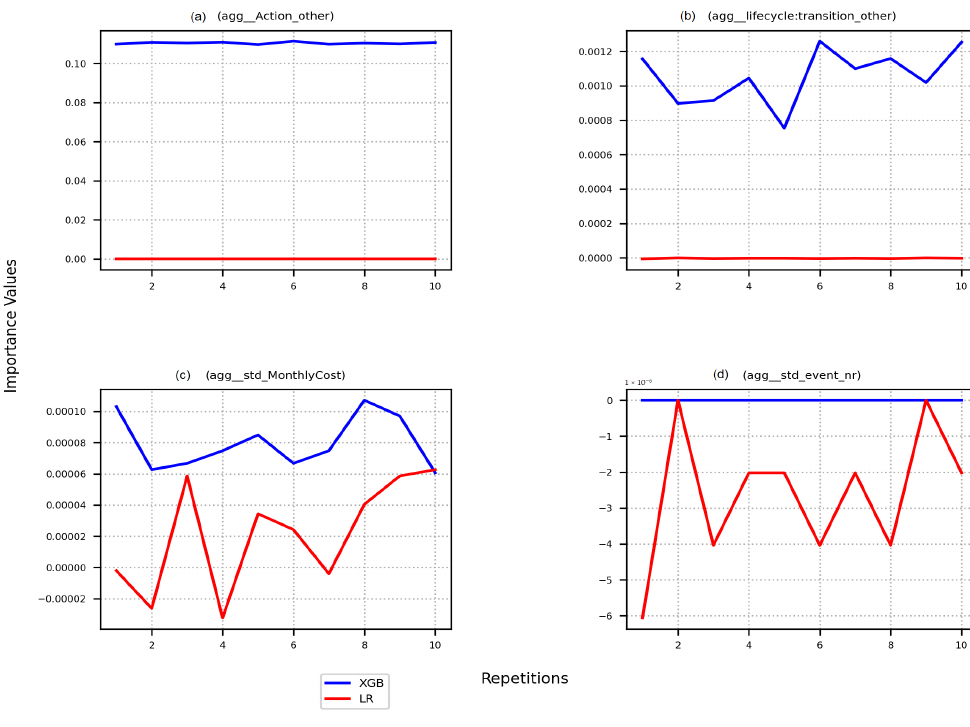
Figure 9. PFI scores of BPIC2017_Accepted event log.